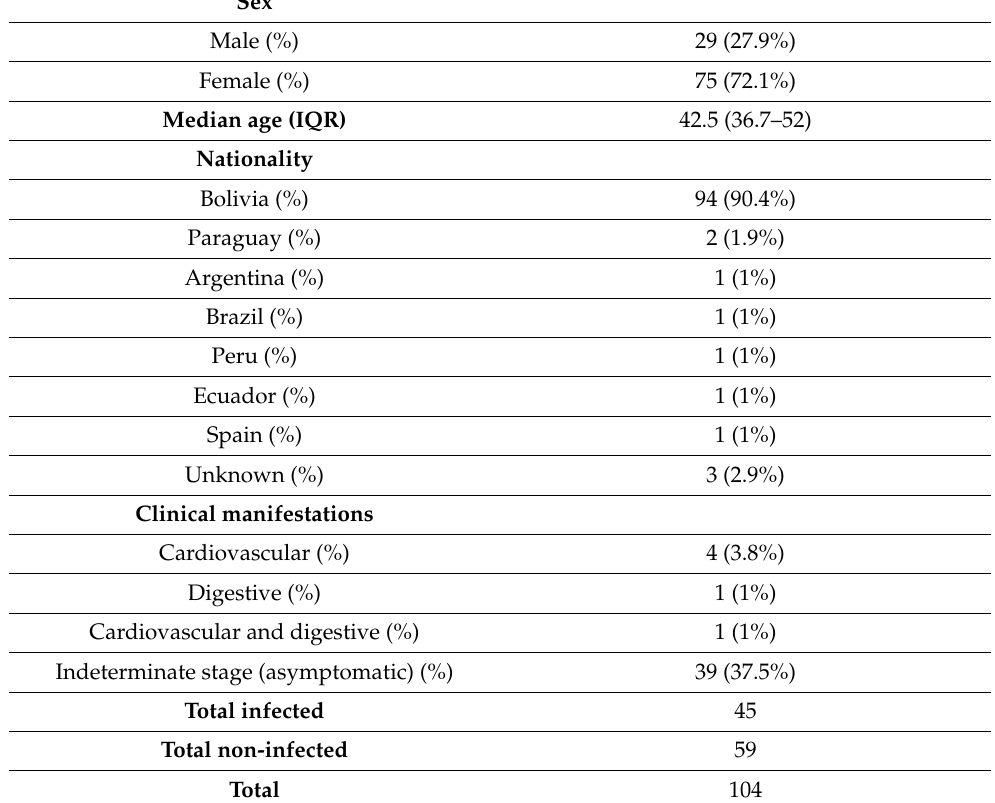
Table 1. Study participant